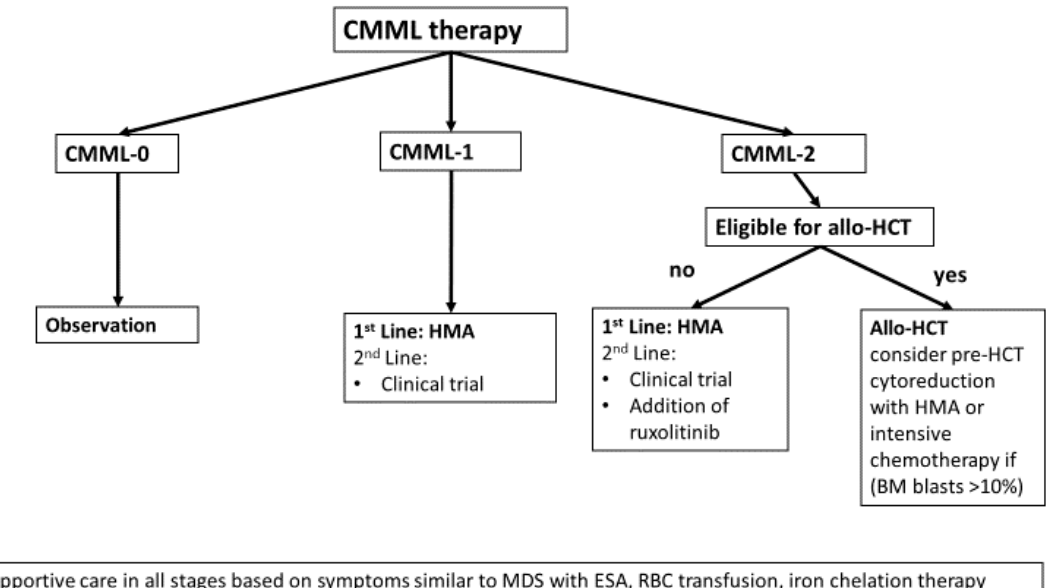
Figure 4. Potential treatment algorithm for CMML. Treatment of CMML should be individualized based on bone marrow and peripheral blast percentage. CMML-0 (<2% blasts in blood and <5% in bone marrow) is managed with observation. For CMML-1 (2–4% blasts in blood and 5–9% in bone marrow) and CMML-2 (5–19% blasts in blood and 10–19% in bone marrow), HMA are the only approved therapy. Especially for CMML-2, allo-HCT should be considered. The addition of ruxolitinib or clinical trial enrollment are additional options. All patients should receive supportive care similar to MDS patients based on their symptom burden with ESA, RBC transfusion, iron chelation, and growth factor support. Hydroxyurea remains a cornerstone of therapy in patients with prominent myeloproliferative disease